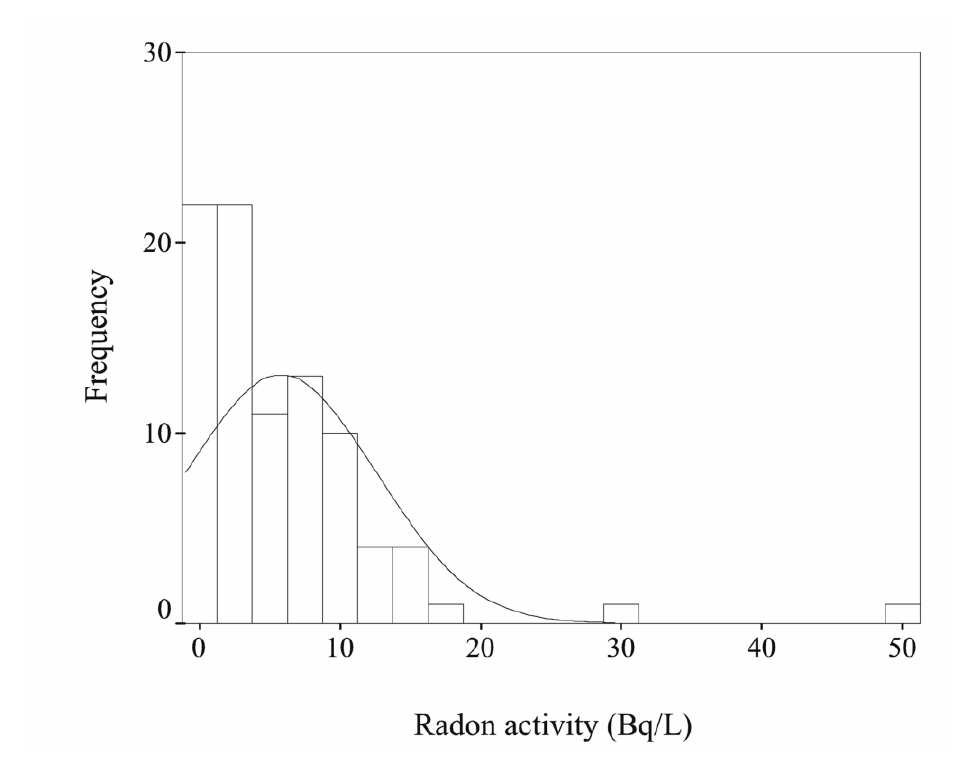
Figure 3. Frequency distribution of 222 Rn activity in drinking water of Beijing